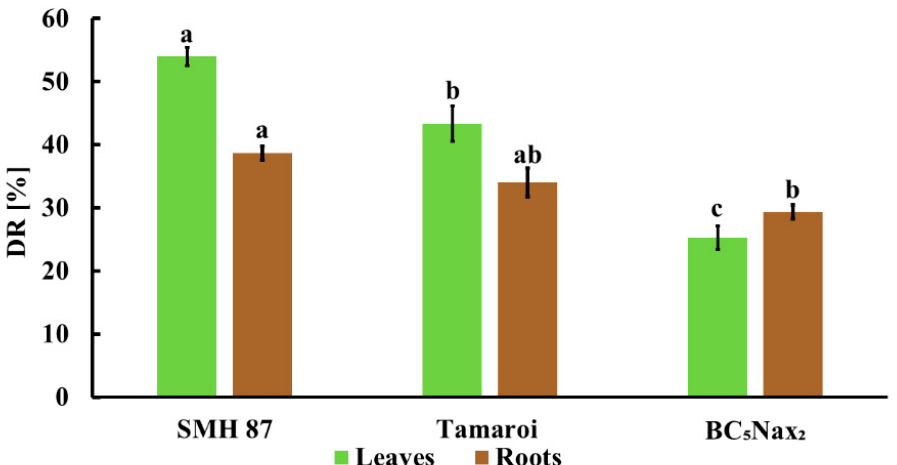
Figure 2. Disease rating (DR) in the leaves and roots of three durum wheat genotypes infected with F. culmorum . The values represent means ( n = 30) ± SE (standard error). Different superscript letters (a–c) for each organ indicate significant differences between means (Duncan’s multiple range test; p < 0.05).